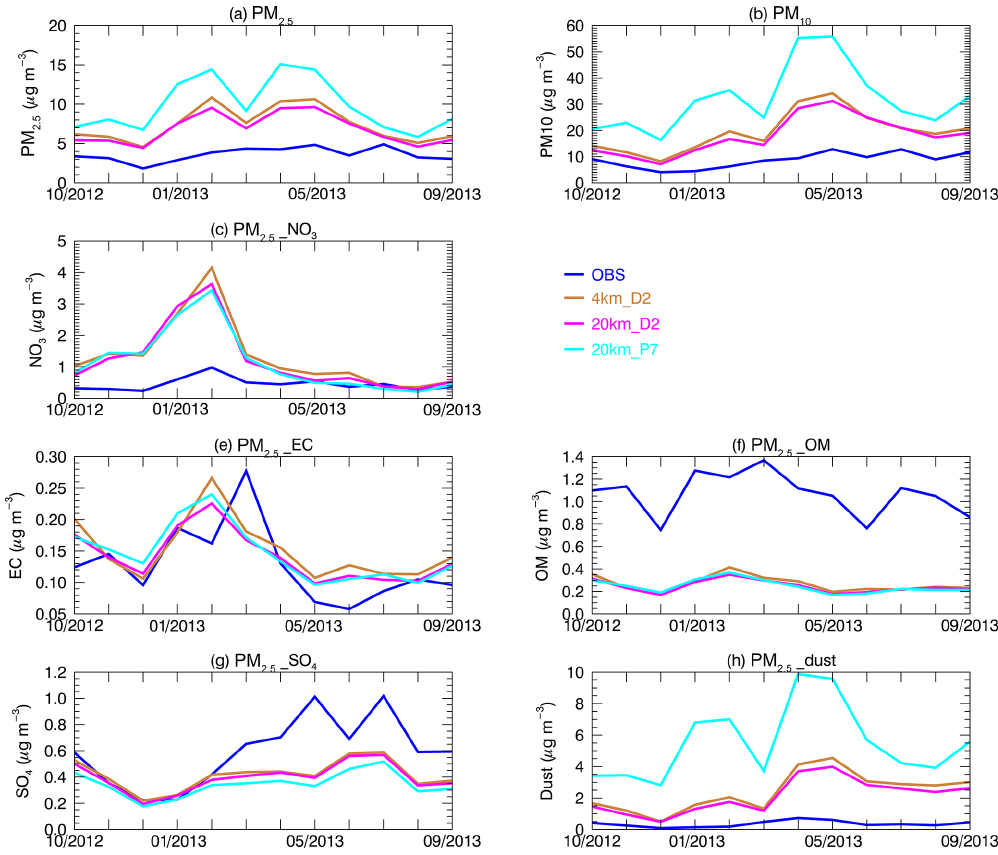
Figure 16. Aerosol mass (µgm − 3 ) for different species from IMPROVE (OBS), the 4km_D2, 20km_D2 and 20km_P7 simulations at Pinnacles,